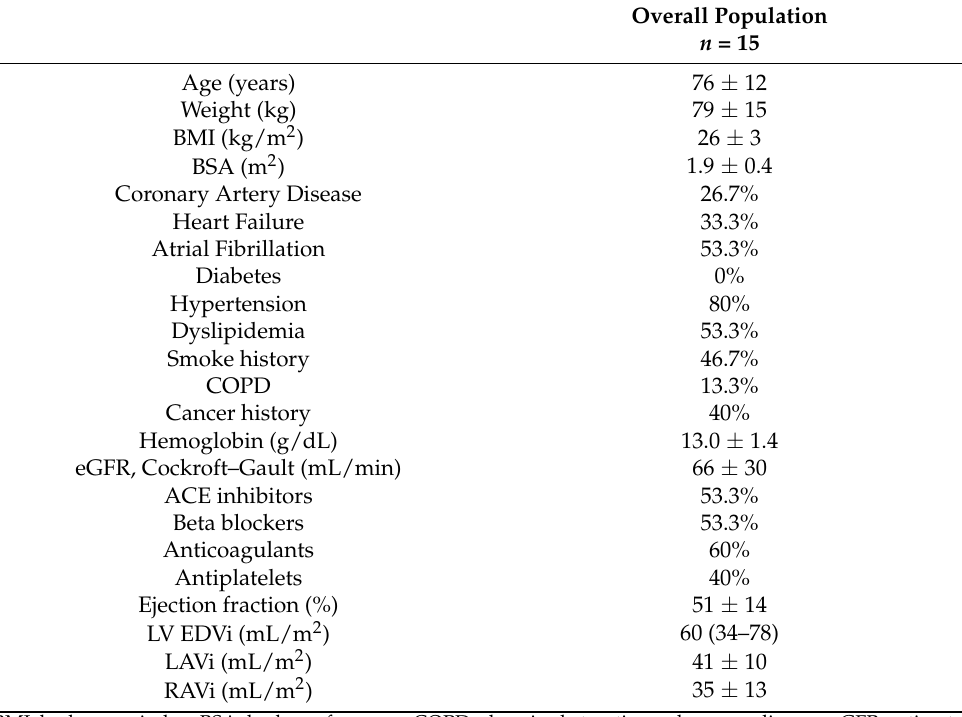
Table 1. Baseline clinical characteristics.